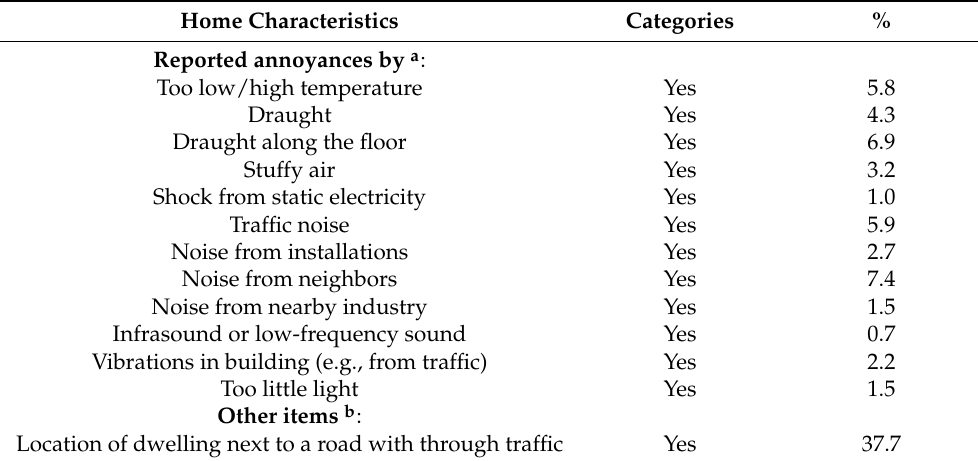
Table 2. Frequency of reported annoyances, n = 16,688.